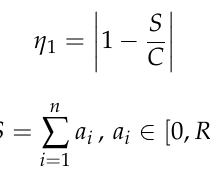
( f ) Figure 21. Comparison of stitching results of the obstacles. ( a ) Physical picture of the obstacle 1. ( b ) Encoding points selection of the obstacle 1. ( c ) Stitching result of the obstacle 1. ( d ) Physical picture of the obstacle 2. ( e ) Encoding points selection of the obstacle 2. ( f ) Stitching result of the obstacle 2.